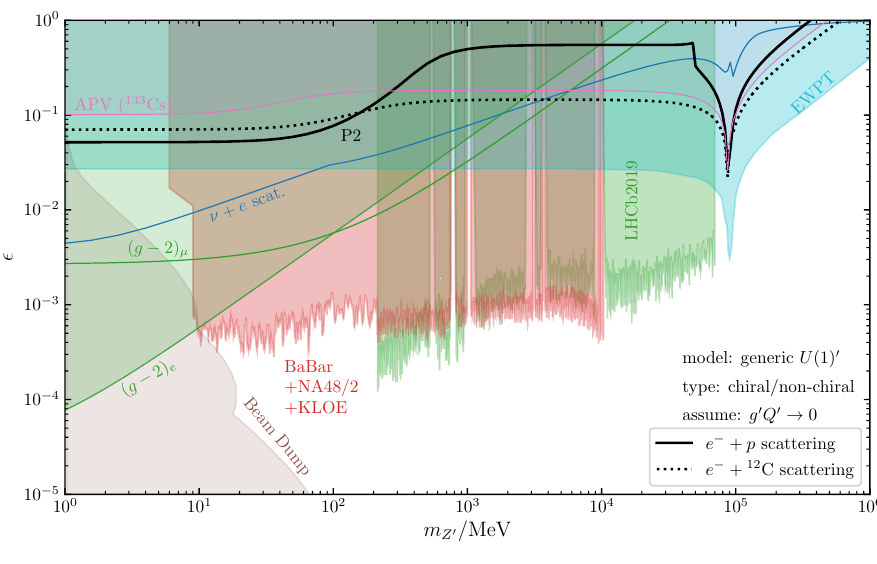
Figure 4 . Sensitivity of the P2 experiment to the generic U(1) 0 model with only kinetic mixing (cid:15) and in the limit of g 0 Q 0 = 0 . The notation is the same as in figure